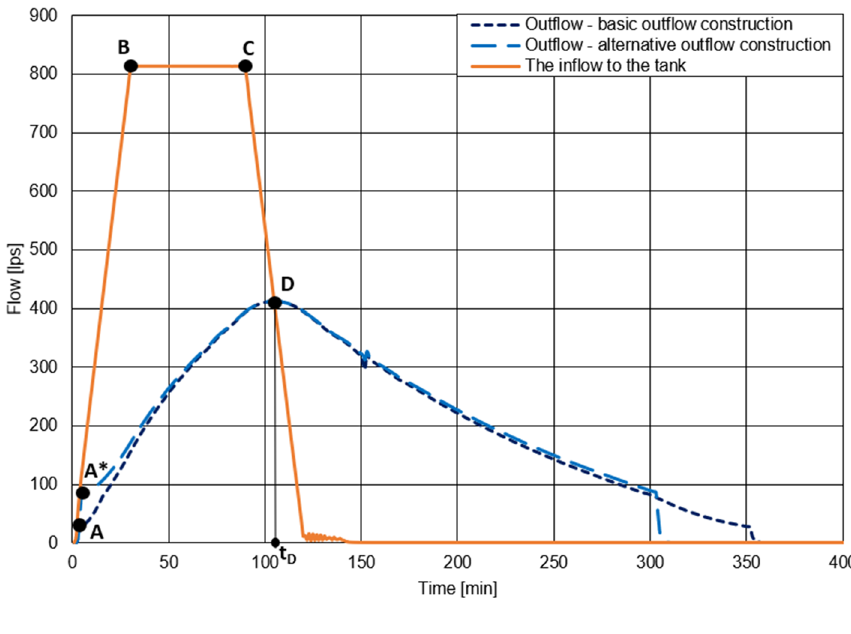
Fig. 8 Depth of stormwater in the tank for different bottom surface areas and different slopes of